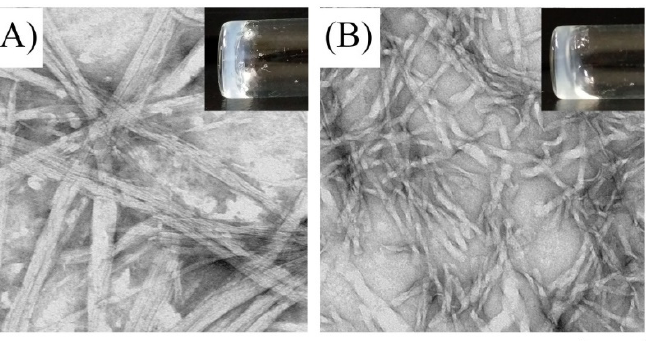
Figure 2. Optical (insets) and negatively stained TEM images of ( A ) Ben-IKVAV and ( B ) PFB-IKVAV at a concentration of 1 wt.% under pH 7.4. (Scale bar: 100 nm.).